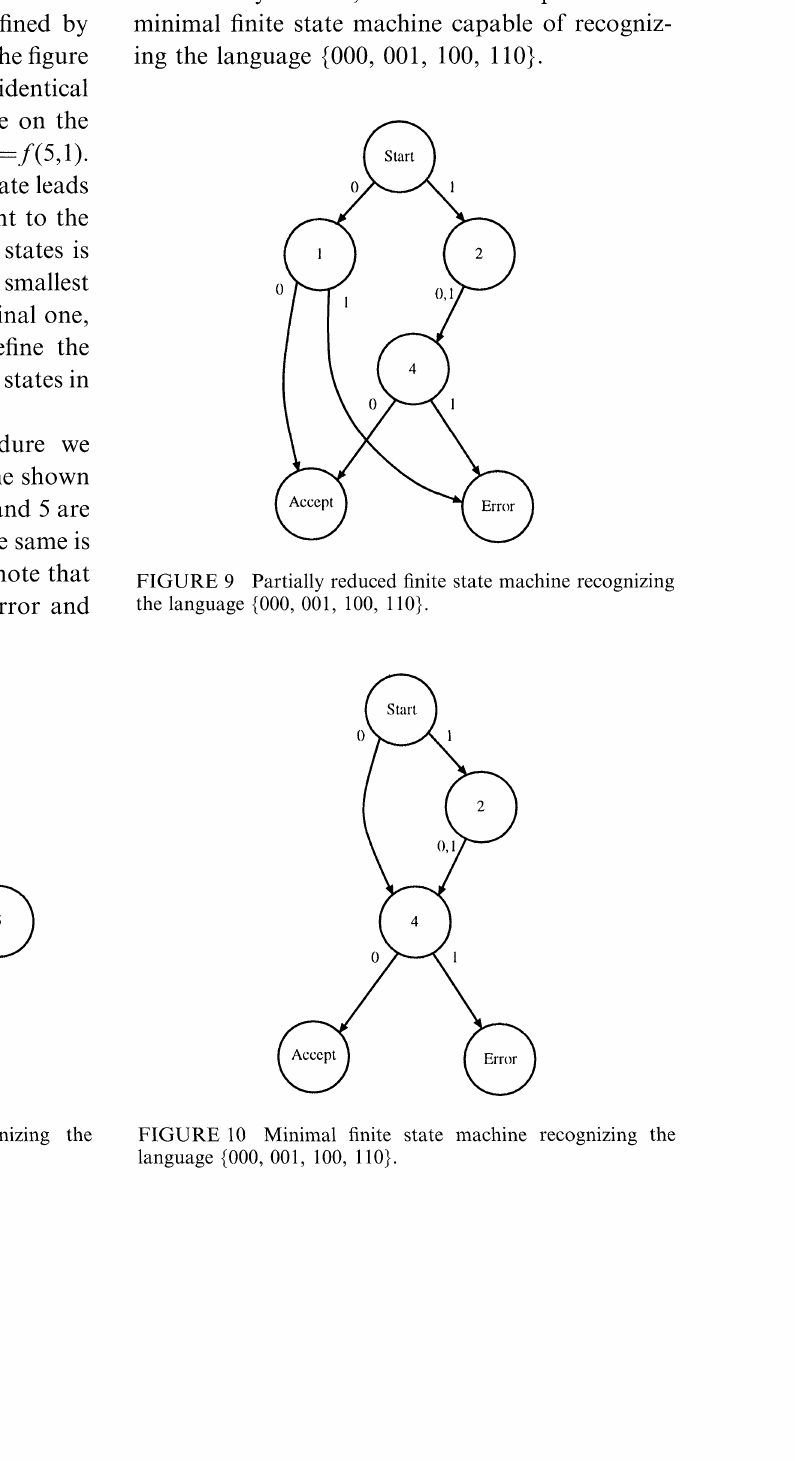
FIGURE 10 Minimal finite state machine recognizing the language {000, 001, 100,